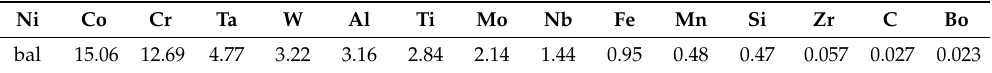
Table 1. Chemical composition of Alloy 11 (wt %) [12].